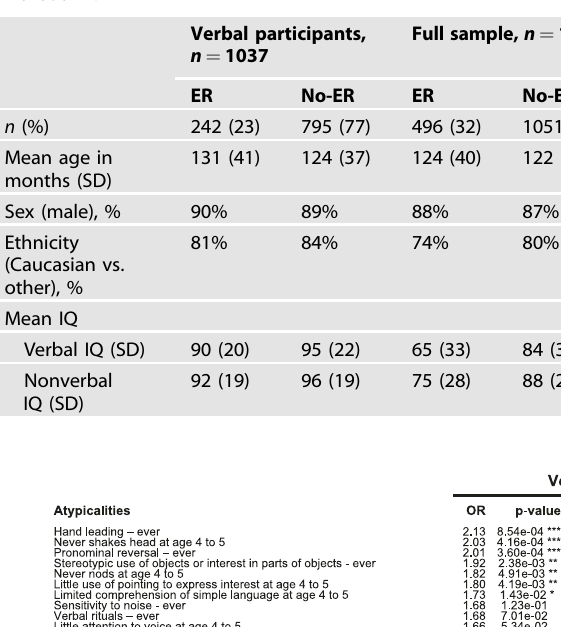
Table 1. Demographic and cognitive data of participants with and without ER.